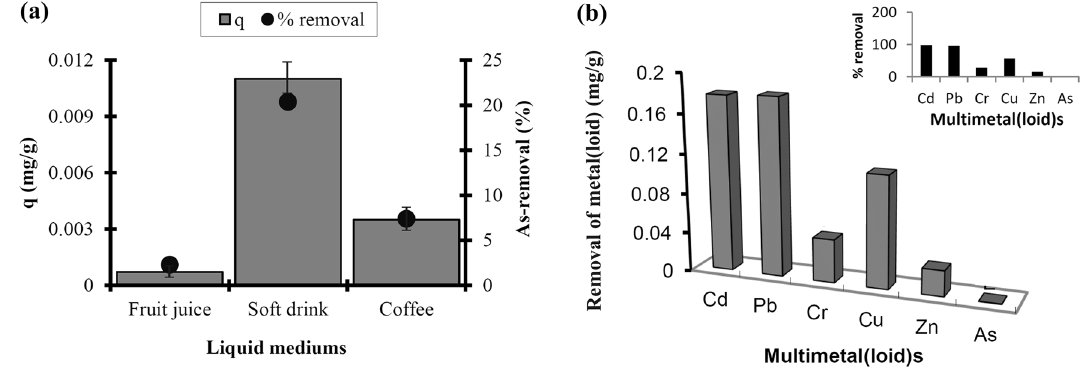
Fig. 5 a Arsenic bioremediation capacity of HS12 strain from fruit juice, soft drink, and coffee; b Heavy metal(loid)s bioremediation capacity of HS12 strain from multimetals and As-contaminated water [inset shows the multimetal(loid)s removal percentage of HS12